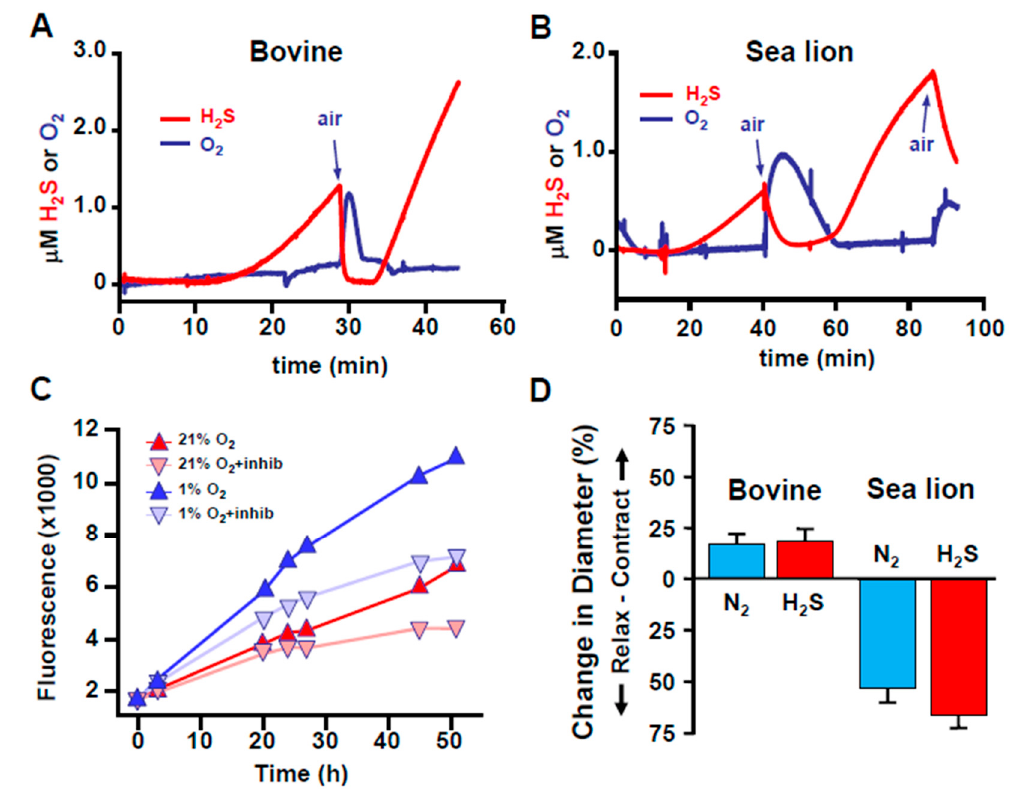
Figure 3. H 2 S production is inversely related to O 2 acutely and chronically. ( A , B ) Relationship between H 2 S and O 2 in homogenized bovine and sea lion lungs measured in real-time with amperometric electrodes. H 2 S is spontaneously produced in hypoxia, rapidly disappears upon exposure to O 2 , and reappears after the O 2 has been consumed. ( C ) Comparison of H 2 S production in HEK293 cells in 21% and 5% O 2 over 52 h monitored with the H 2 S-sensitive fluorophore, AzMC. More H 2 S was produced by cells in 5% O 2 over this period. Inhibition of H 2 S biosynthesis by cystathionine β -synthase, cystathionine γ -lyase and 3-mercaptopyrucate sulfur transferase with aminooxyacetate, propargyl glycine and compound 3, respectively (+inhibs) decreased but did not prevent H 2 S production in either environment. ( D ) Effects of hypoxia (N 2 ) and H 2 S on the diameter of cannulated and pressurized bovine and sea lion pulmonary resistance arterioles. Vessels were slightly precontracted with the thromboxane A2 analog, U-46619 (10 − 6 M) and exposed to either hypoxia (N 2 ) or 3 × 10 − 4 M H 2 S. Both N 2 and H 2 S contracted bovine arterioles but relaxed sea lion vessels. A, B and D from [10]; C from [48], Reproduced with permission from Kenneth R. Olson et al. [10]. Reproduced with permission from [48], copyright 2019 John Wiley & Sons Ltd.